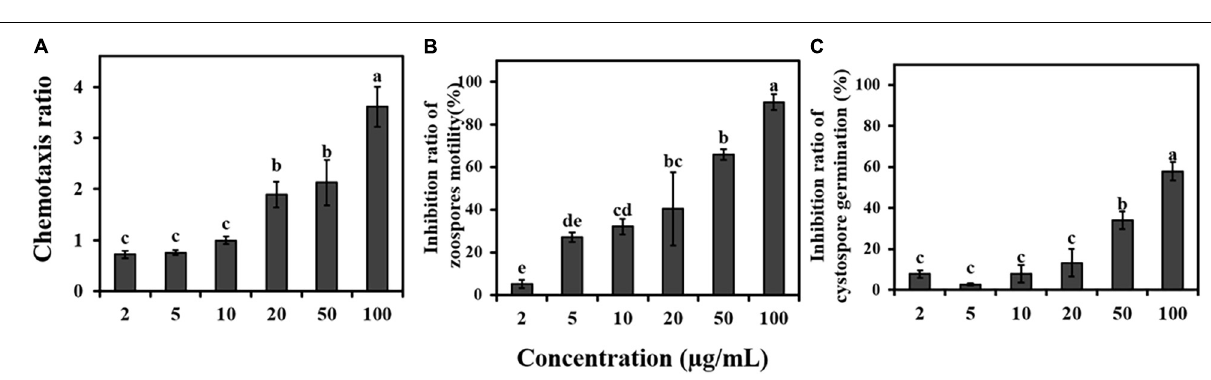
FIGURE 3 | Effects of fennel root exudates on zoospores at different stages. (A) Chemotaxis. (B) Motility. (C) Cystospore germination. Significant differences are based on one-way ANOVA. The error bars indicate the standard error of the means ( n = 3). Lower case letters show significant differences in the inhibitory effect at different stages at the 0.05